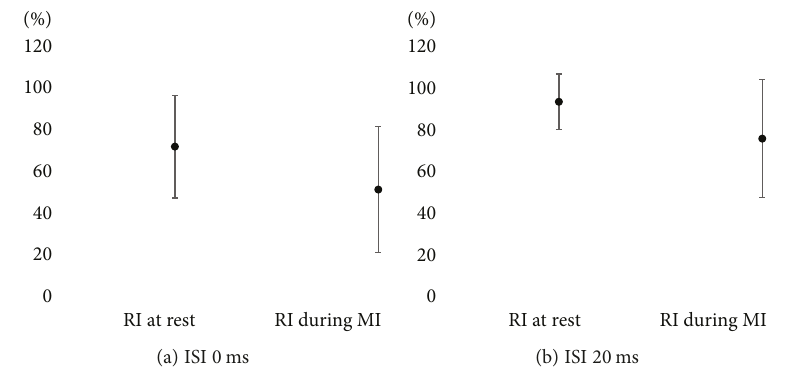
Figure 1: Comparison between reciprocal inhibition at rest and reciprocal inhibition during motor imagery. Signi fi cant changes were found in reciprocal inhibition (RI) during motor imagery (MI) at both an interstimulus interval (ISI) of 0ms and 20 ms compared with RI at rest. Data are the mean ± standard deviation.